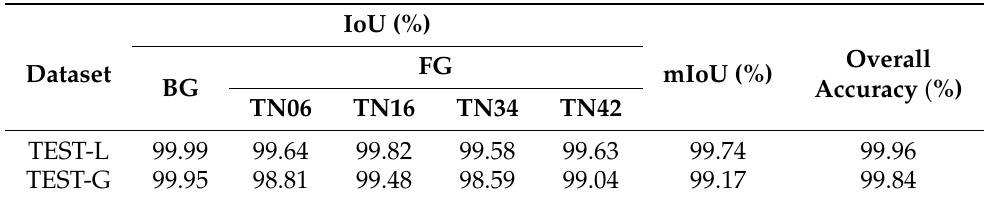
Table 2. Background (BG) and foreground (FG) segmentation, and template segmentation in pre- dicted foreground points.